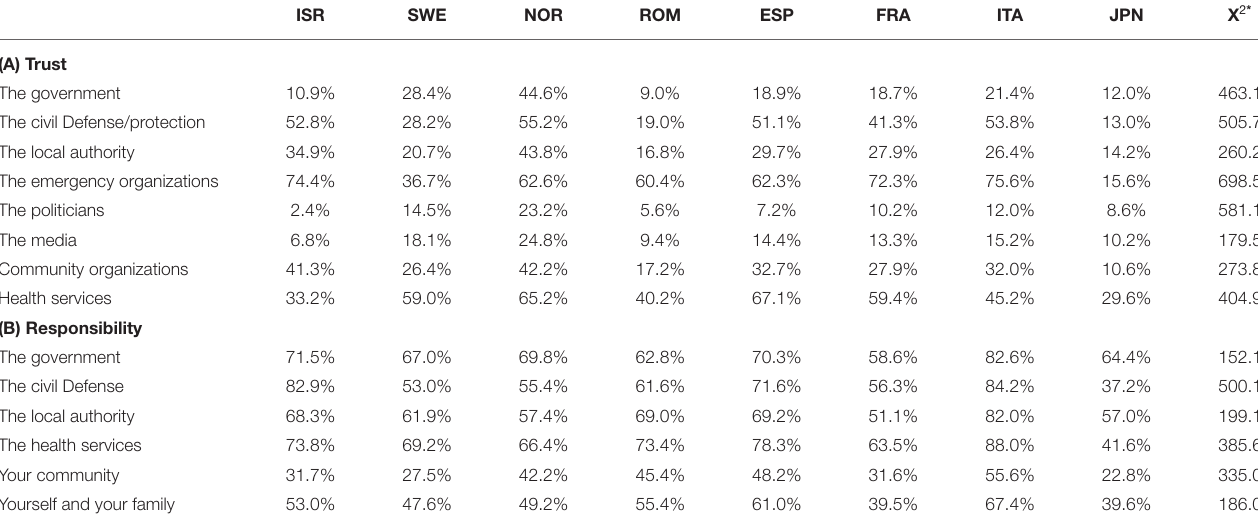
TABLE 2 | Comparison of top answers proportion for trust and perception of responsibility between countries ( N = 4,013). ISR SWE NOR